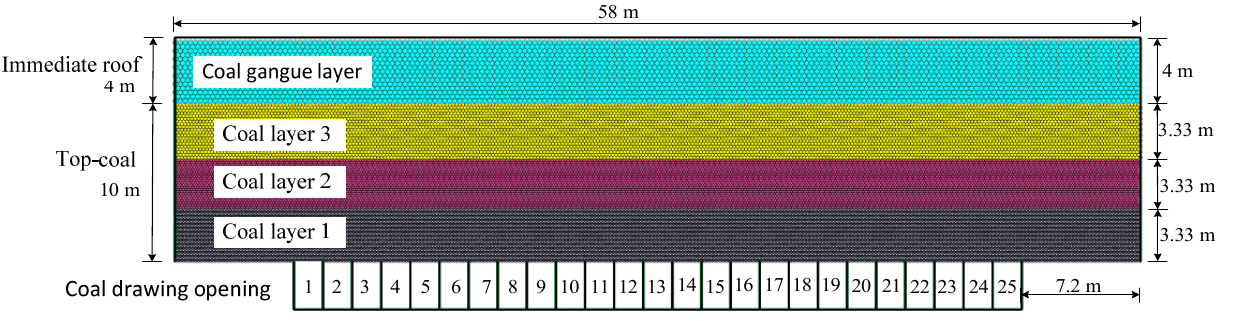
Figure 3. Mining technology of working face.